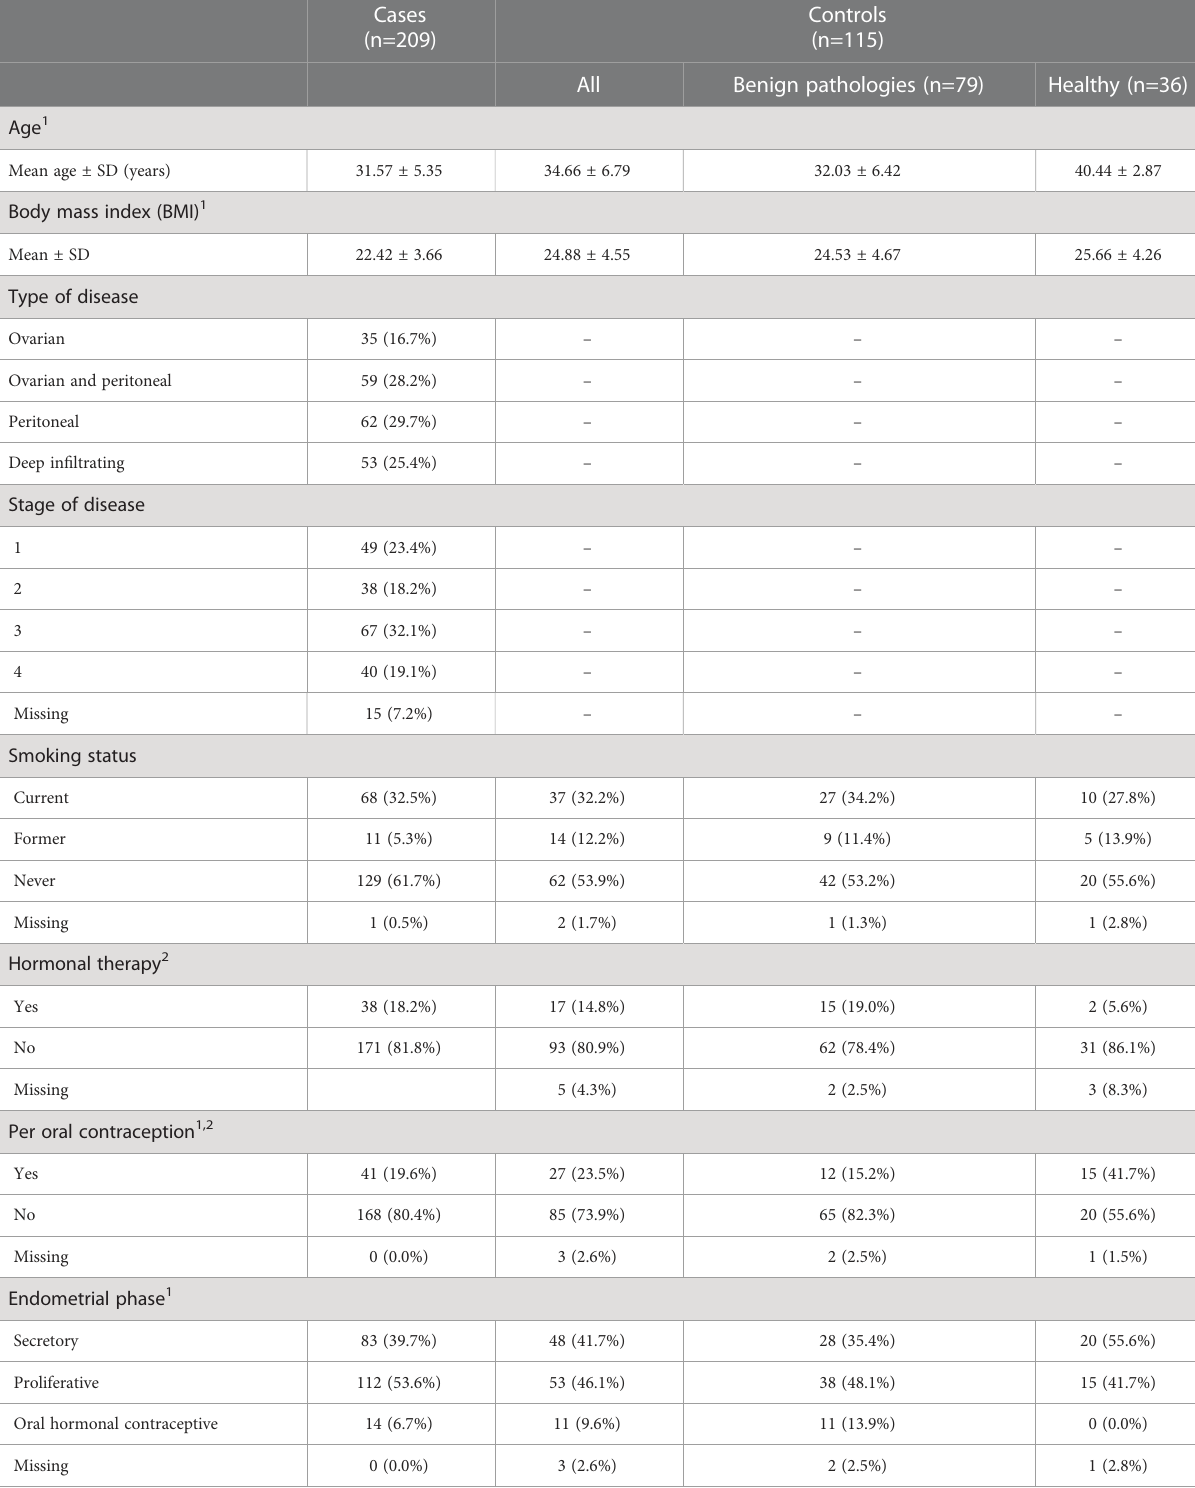
TABLE 1 Characteristics and clinical data of endometriosis cases (n=209) and controls